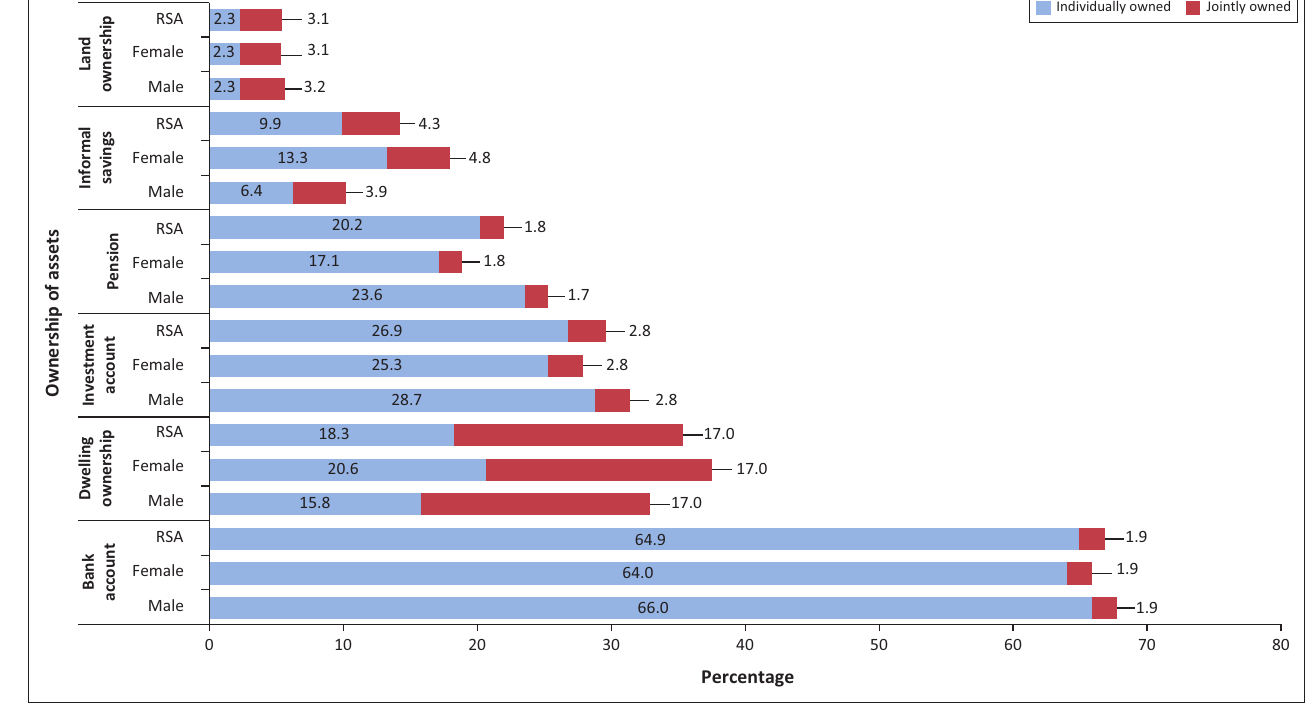
FIGURE 1: Individual ownership of assets for individuals aged 18 years and older by sex,